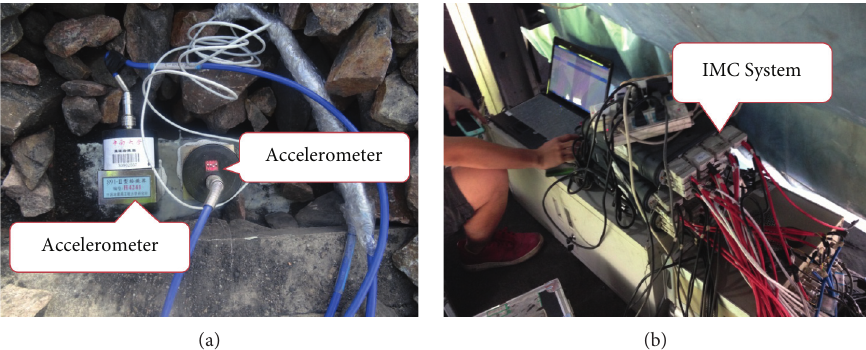
Figure 11: Measurement devices in the field test: (a) measurement of the acceleration of the bridge and (b) data acquisition system (IMC). 0.81.0 0.6 –1.0–0.8–0.6–0.4–0.20.00.20.4